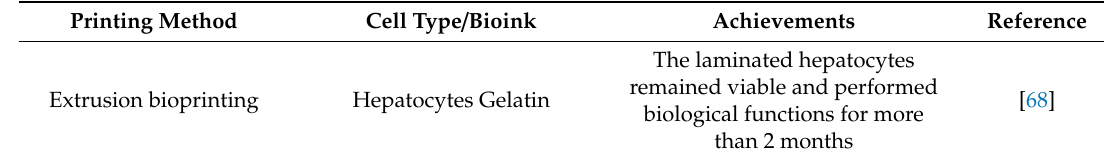
Table 2. A short summary of outstanding recent liver bioprinting